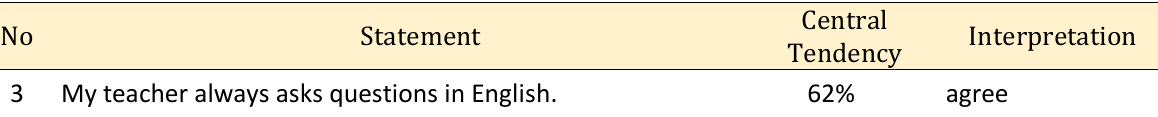
Table 3. Statement 3 questionnaire and interview